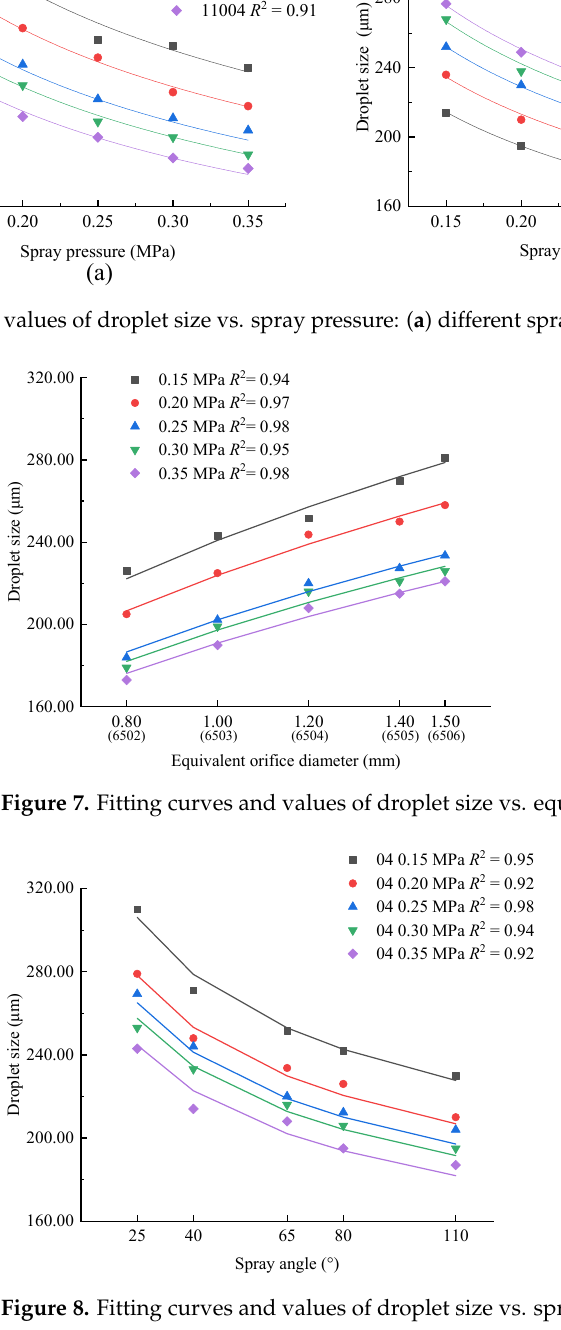
Figure 6. Fitting curves and values of droplet size vs. spray pressure: ( a ) different spray angles; and ( b ) different flow rates.